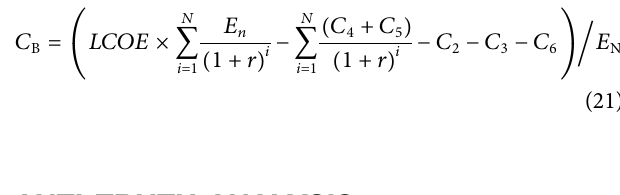
FIGURE 1 | Schematic diagram of available capacity of different retired power